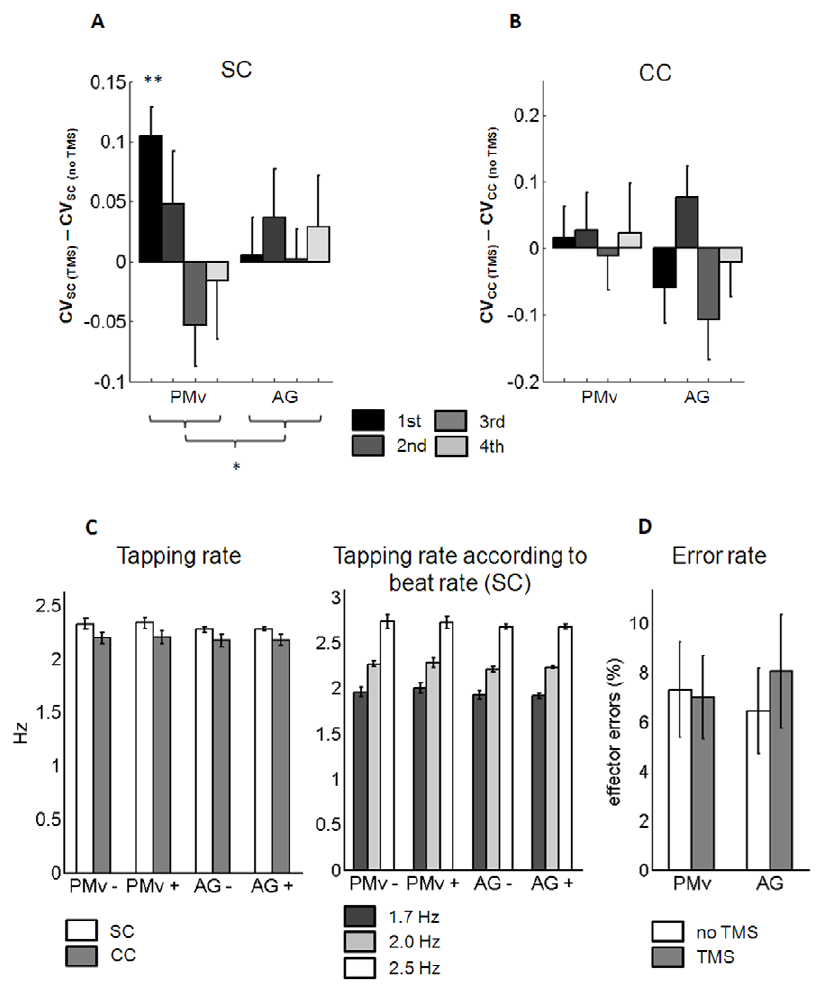
Figure 3. Behavioral effects of rTMS. A : Auditory-motor timing variability: Coefficient of variation of tap-to-beat asynchrony in the synchronization condition (CV SC ) plotted as the difference between TMS and no TMS (baseline) for each of the four sub-blocks of the PMv and AG sessions, respectively. Results reveal a significant interaction between SITE (PMv/AG), TMS (no TMS/TMS) and TIME (1 st /4 th sub-block) (* denotes p=0.045 in a repeated measures ANOVA) due to an increase of CV SC in the first sub-block after PMv stimulation (** denotes p , 0.01, Bonferroni corrected). B : Control 1, Motor timing variability: Coefficient of variation of tap-to-tap’ asynchrony in the self-paced control condition (CV CC ) plotted as the difference between TMS and no TMS (baseline) for each of the four sub-blocks of the PMv and AG sessions, respectively. C : Control 2, Tapping rate in the SC and CC (left side) and tapping rate according to the beat rate of auditory rhythms in the SC (right side). ‘‘ + ’’ refers to the scan preceded by rTMS; ‘‘ 2 ’’ refers to the scan not preceded by rTMS. D : Control 3, Effector error rate. Error bars denote standard errors of the